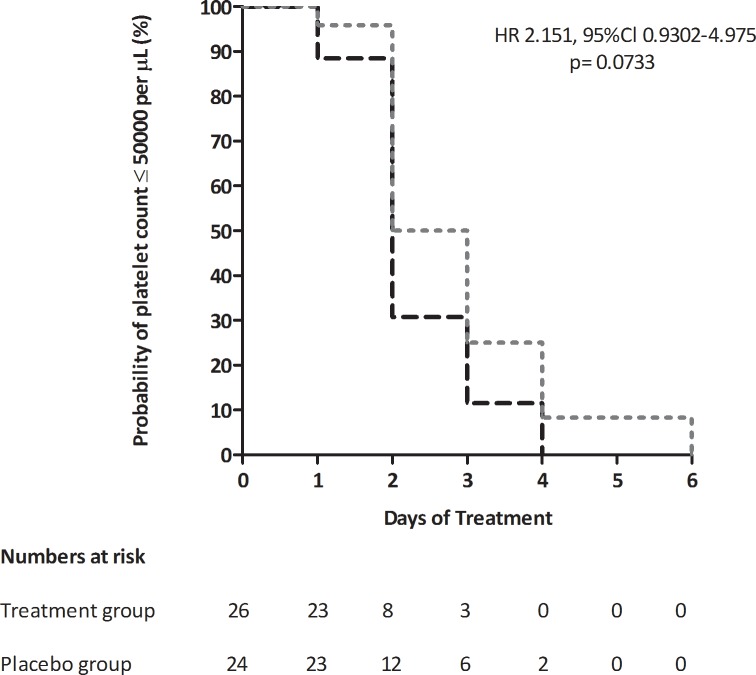
Kaplan-Meier estimates of probability of platelet count of ≤ 50000 per μL by day 6 in treatment group (black) and placebo group (grey).HR denotes hazard ratio.